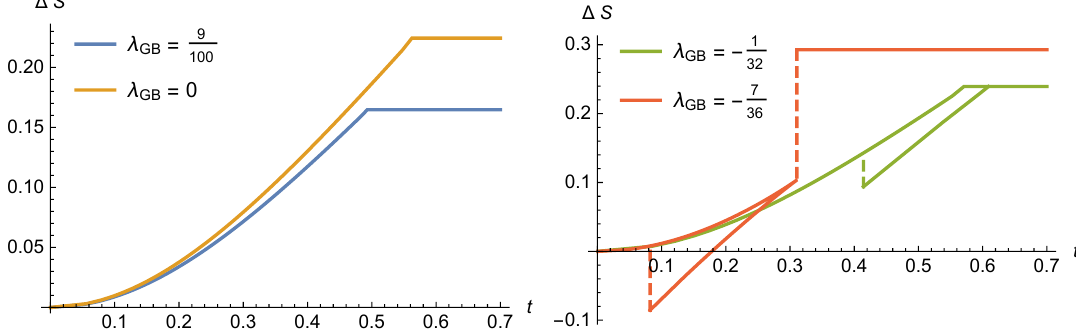
Figure 12 . Three kinds of Page curve for eternal Gauss-Bonnet black holes with d = 4 . Case I (orange and blue lines obeying bound (4.23)): the entanglement entropy keeps increasing until it saturates a constant value. Case II (green line obeying bound (4.23)): the entanglement entropy firstly increases, then drops suddenly and continues to increase until it saturates a constant